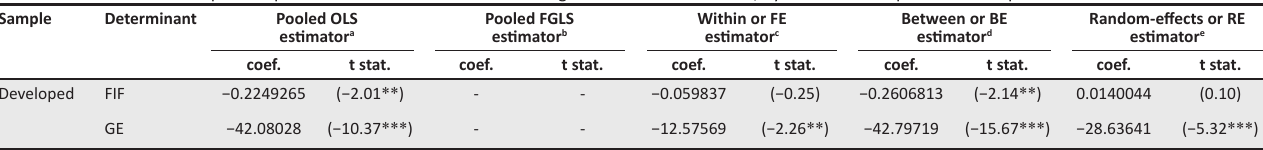
TABLE 12: Variation of corruption depends on fiscal freedom variable and government effectiveness, by level of development: Developed. Sample Determinant Pooled OLS